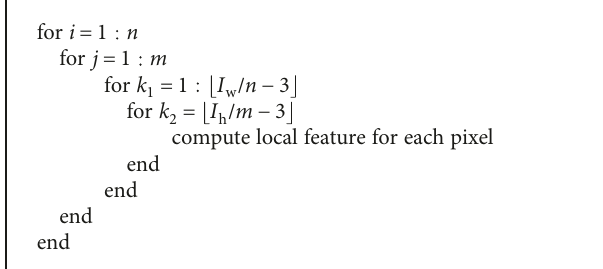
Pseudocode 3: Pseudocode for CSA-SURF feature extraction